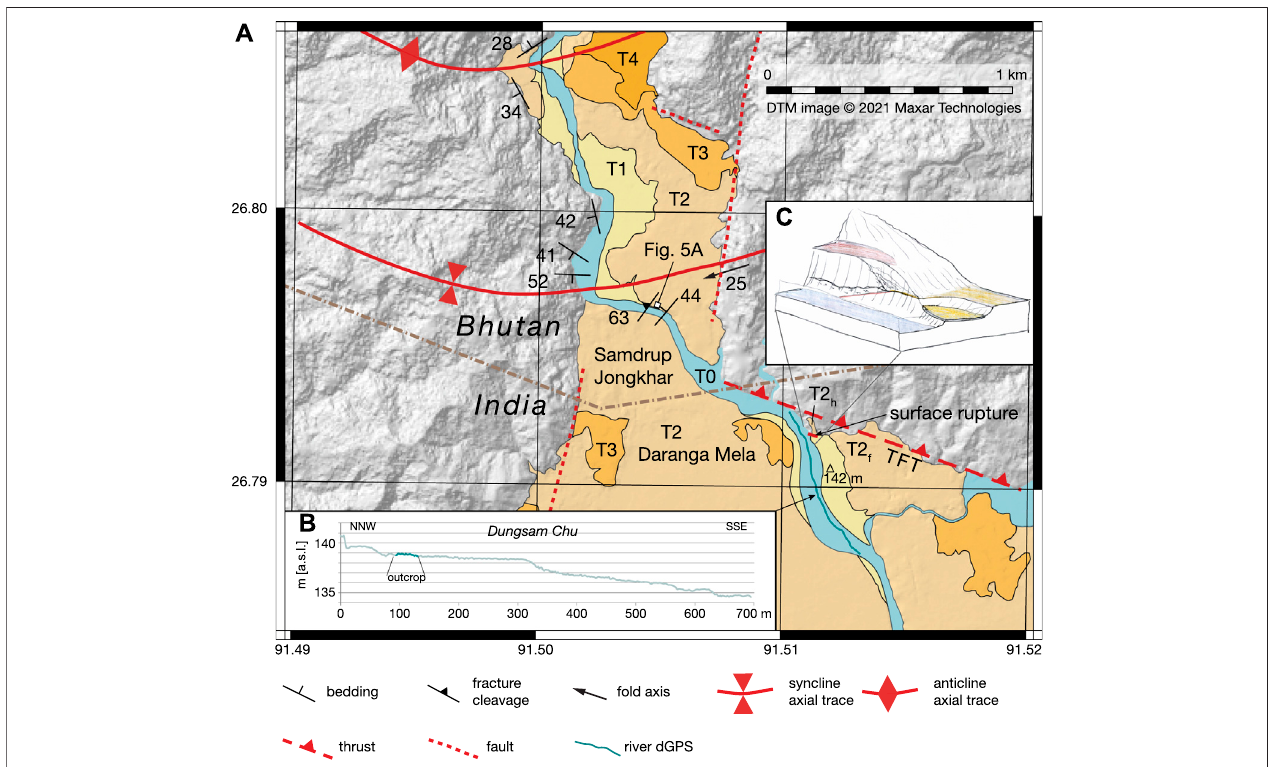
FIGURE 2 | Geomorphic and structural map of the study area. (A) The digital terrain model (DTM) with a horizontal resolution of 0.5 m was derived from Maxar stereopairimagerybyMaxarTechnologiesandfurtherprocessed usingQGIS(v.3.16.3).ThegeologicalobservationsarefromGrujicetal.(2018)and ourobservations. TheriverterracesweremappedontheoriginalDTM. (B) Riverpro fi leacquiredbythedifferentialGPS.Themappedsegmentoftheriverisindicatedonthemap. (C) Draft of the paleoseismic exposure by Luca Malatesta, LM (U of Lausanne, 2019). River terraces T1 and T2 were observed and measured in the fi eld; terrace T2h (hangingwall)inredisinferredtobethesameasterraceT2f(footwall)inorangebutupliftedbythesurface-rupturingearthquake.Pointmarked142istheelevationabove sea level in meters and location of the base station for differential GPS